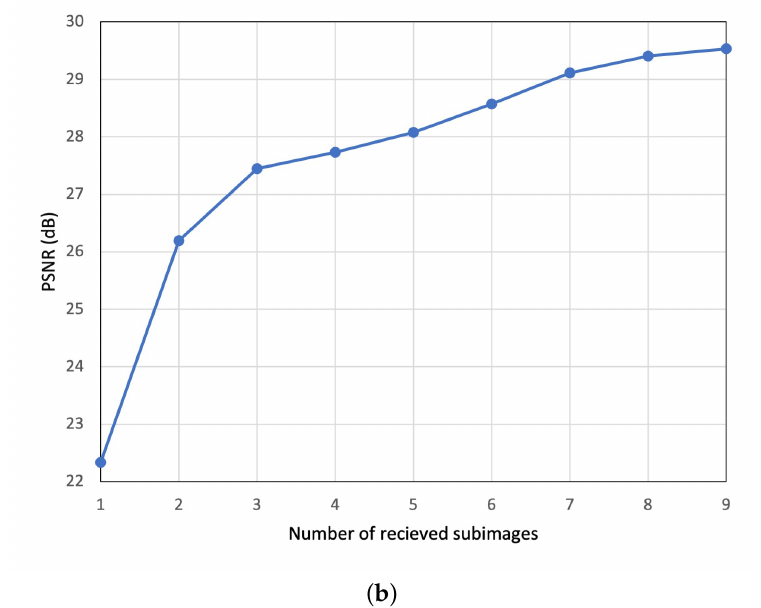
Figure 4. Progressive decompression of Elaine test image. ( a ) Improvement in visual quality as more subimages are received. ( b ) Trend of PSNR score as subimages are